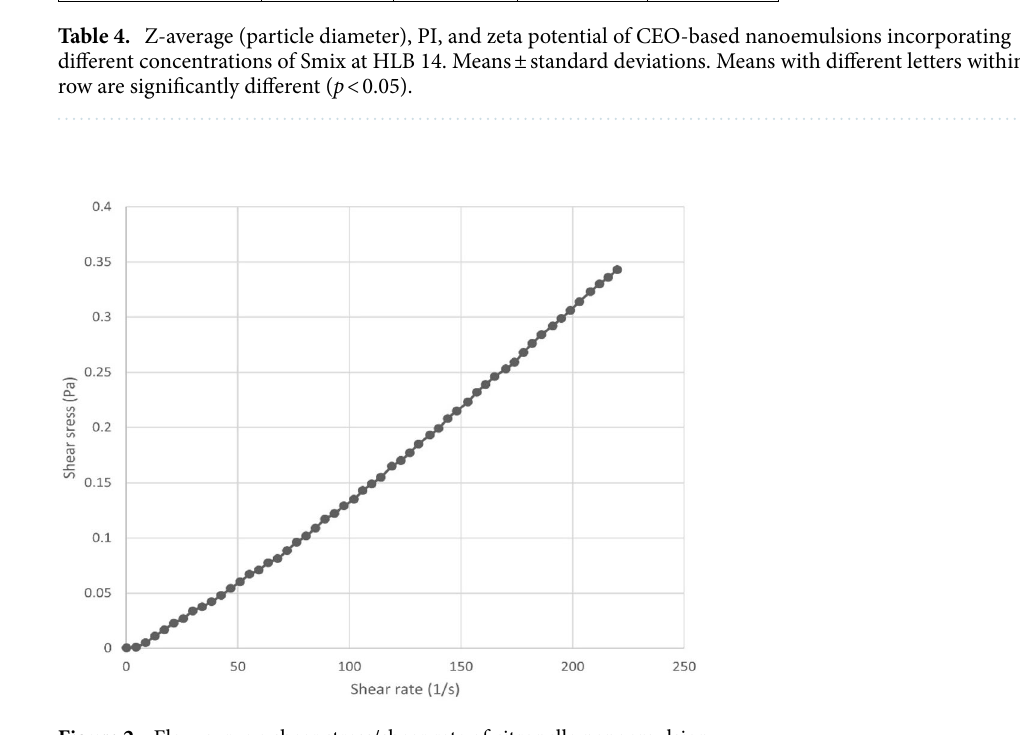
Figure 2. Flow curve a shear stress/shear rate of citronella